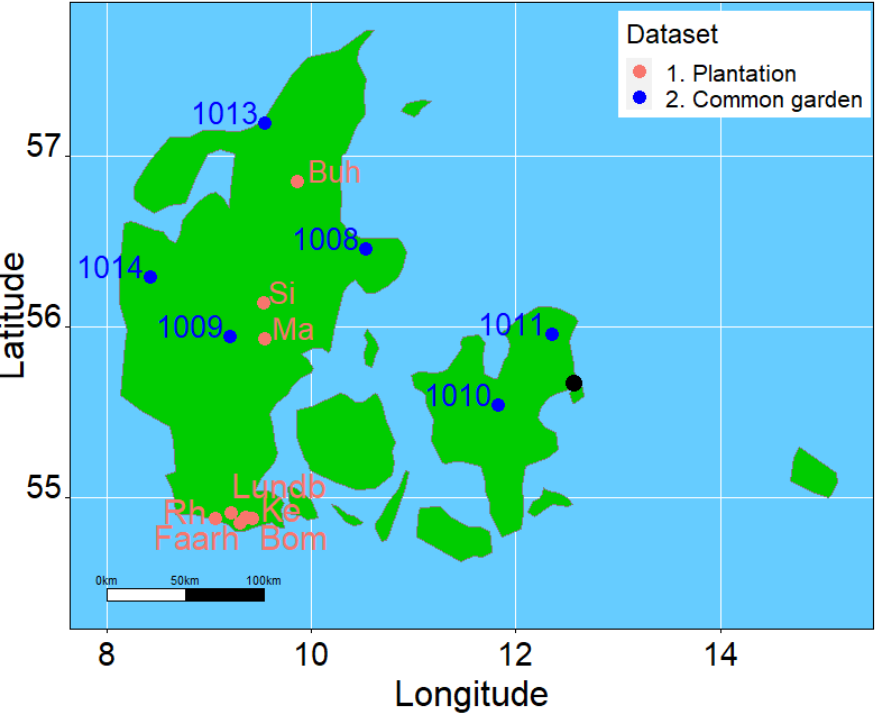
Figure 1. Map of Denmark with site locations. Site codes are explained in Table 1. The second set of data (dataset 2; in total 36 sampled trees) originates from Norway spruce stem discs taken from a Danish common garden experiment with 8–10 commonly used tree species in Danish forestry, covering six trials in Denmark sampled in winter 2012 [9]. At the time of sampling, these trees were 48 years old. Mean annual temperature at the trials ranges between 8.0 ◦ C and 8.7 ◦ C, and annual precipitation ranges between 536 and 748 mm based on E-OBS estimates over period 1961–2012. In total, four of the ex- periments were established on cropland with sandy soils and sandy loam, one experiment was established near the west coast on sandy soil/dunes, and the last was established on heathland (see Huang et al. [9] for more